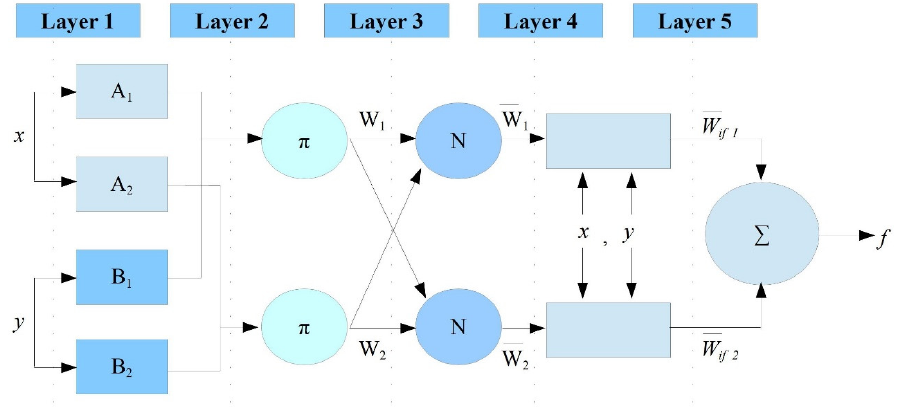
Figure 3. The structure of the ANFIS.